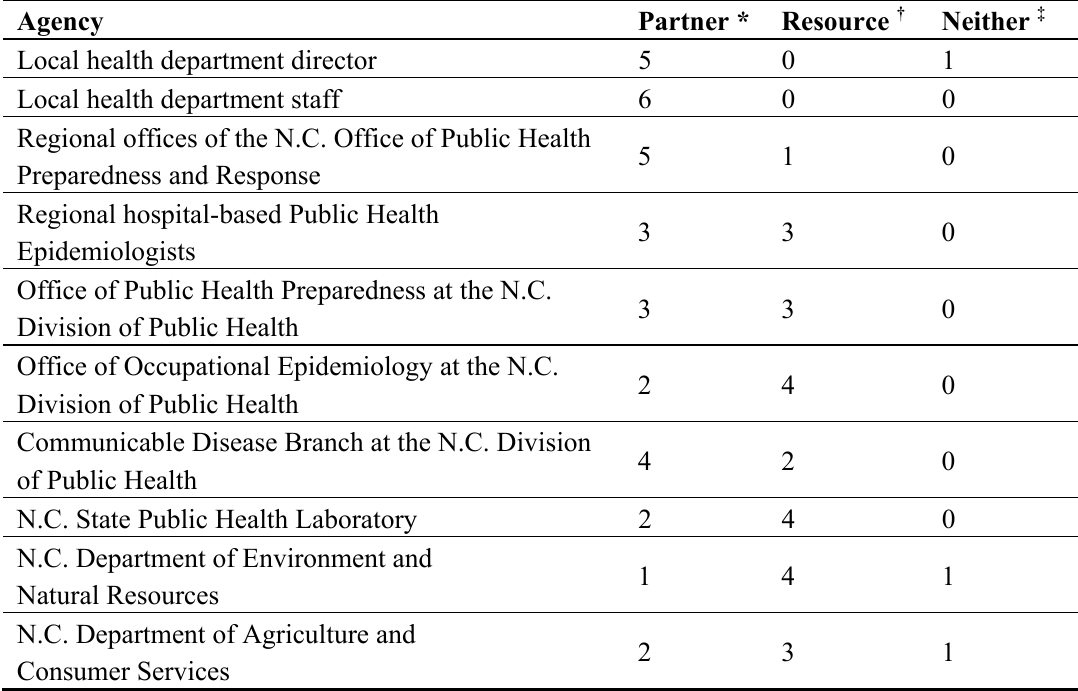
Table A1. Partnerships and collaborations with local agencies reported by key informants.